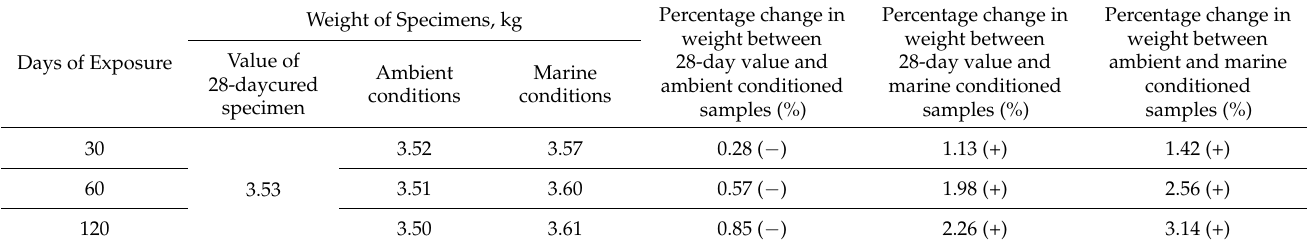
Table 4. Comparison of weight changes under ambient and marine exposure conditions.